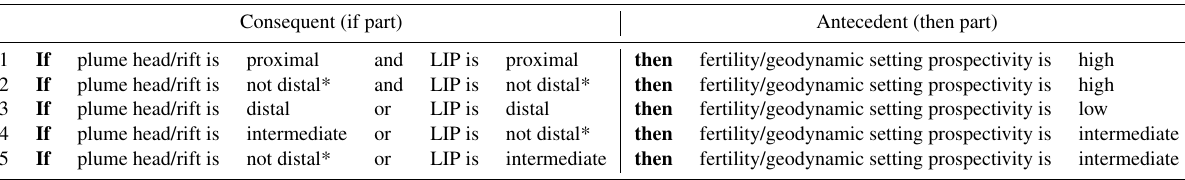
Table A2. Fuzzy if–then rules used for generating fuzzy prospectivity maps for fertile sources and favourable geodynamics settings.